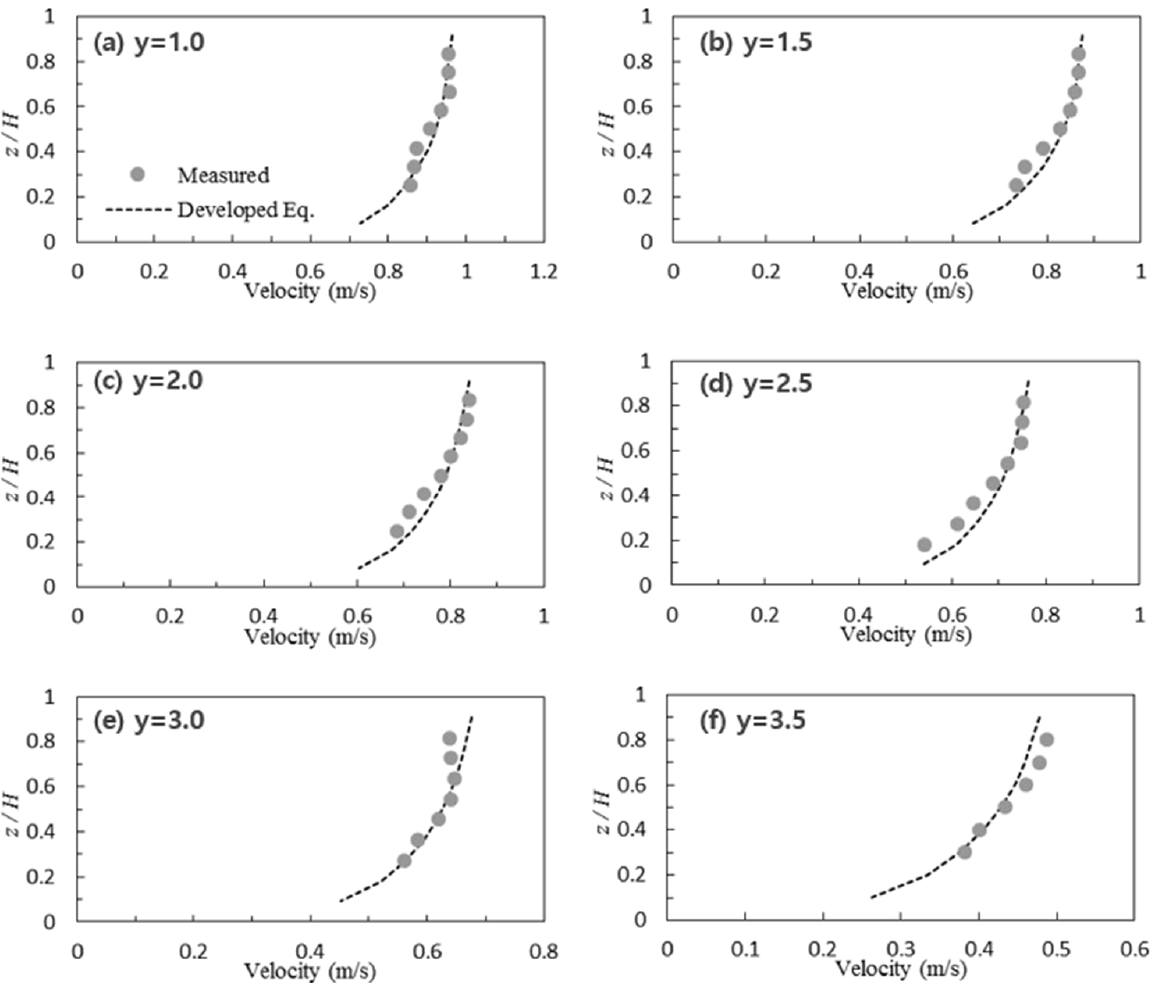
Figure 7. Comparison between measured velocity (dot) and that estimated by Equation (7) (line) at Section S4 of AMC 315 in nature-like channel (y denotes lateral coordinate from left to right bank).